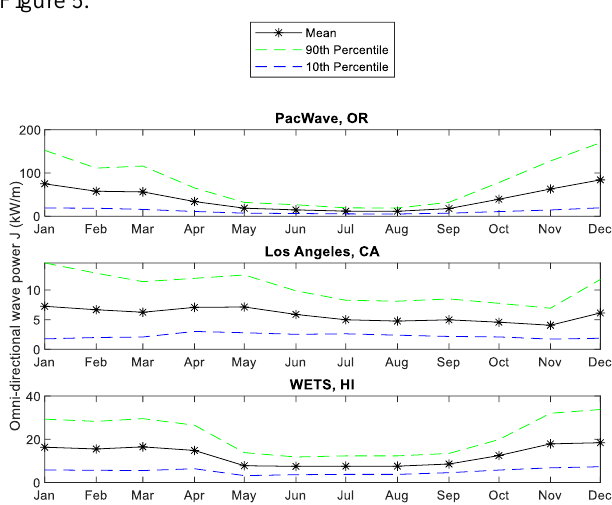
Figure 5: Monthly mean, 10 th , and 90 th percentiles of omni- directional wave power (J) from 2000-2010 at each site At all locations, the maximum 𝐽 s are seen during the winter months from Nov-Mar, followed by the minimum 𝐽 s occurring in the summer from May-Sept. This was expected, as winter months possess more energetic wave climates due to increased storms [21]. During this time of year, the percentile values are noticeably more varied from the mean, indicating a widespread range of 𝐽 values. By contrast, in the summer, these locations see less varied percentile measurements, due to a less energetic sea state. Details regarding the selected locations for analysis can be found in Table